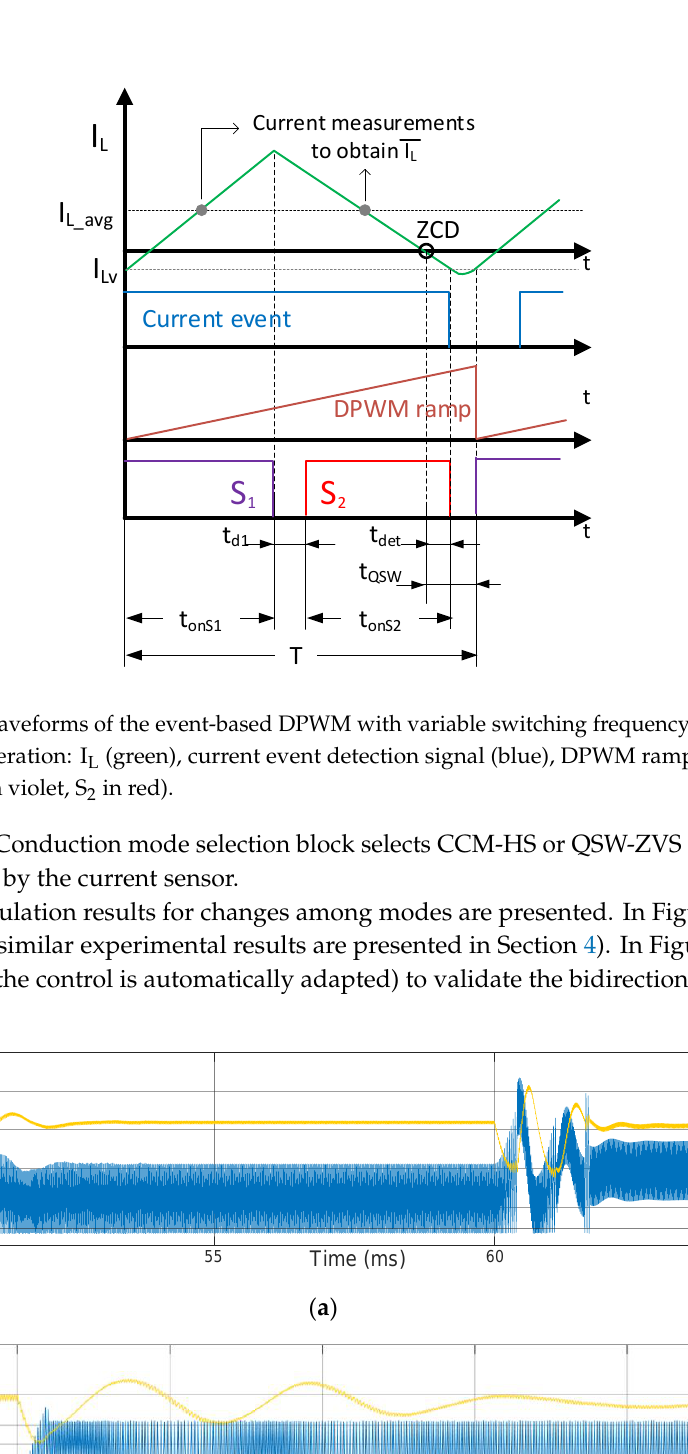
Figure 9. Simulation results changing among conduction modes. ( a ) Power flows from V 1 to V 2 and changes from 6.2 kW to 3.5 kW at t = 50 ms and from 3.5 kW to 6.2 kW at t = 60 ms are promoted. ( b ) Power flows from V 2 to V 1 and change from 8 kW to 3.2 kW at t = 50 ms is promoted. V 2 in yellow and I L in blue.